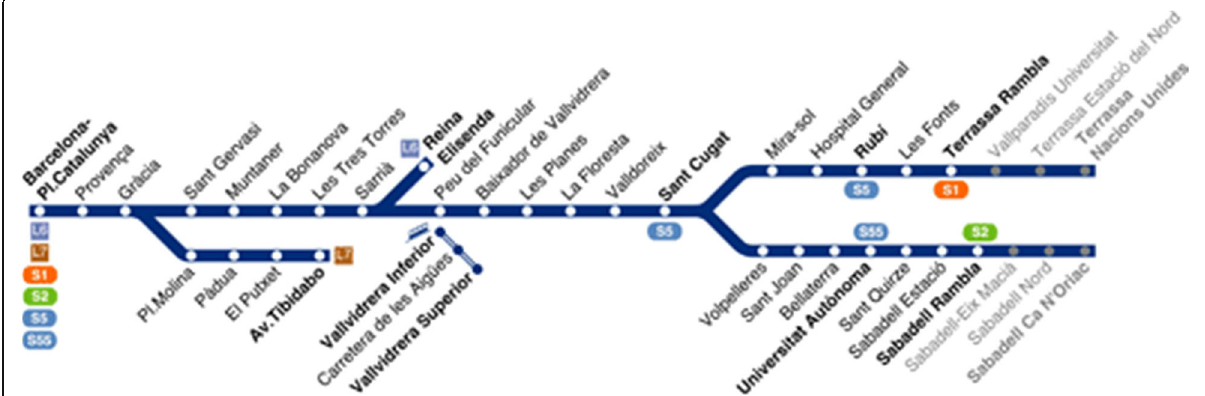
Fig. 6 Map of FGC Barcelona-Vallès